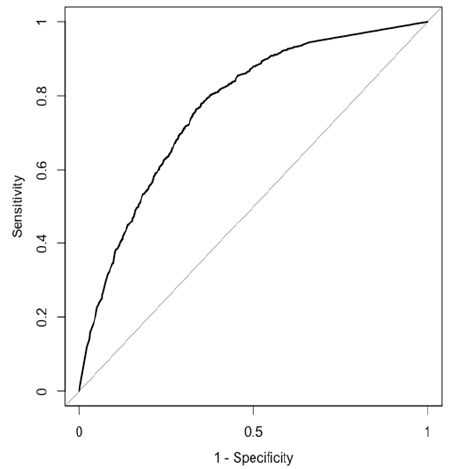
Figure 2. ROC curve for boosting. (AUC = 0.769, F-score = 0.744).